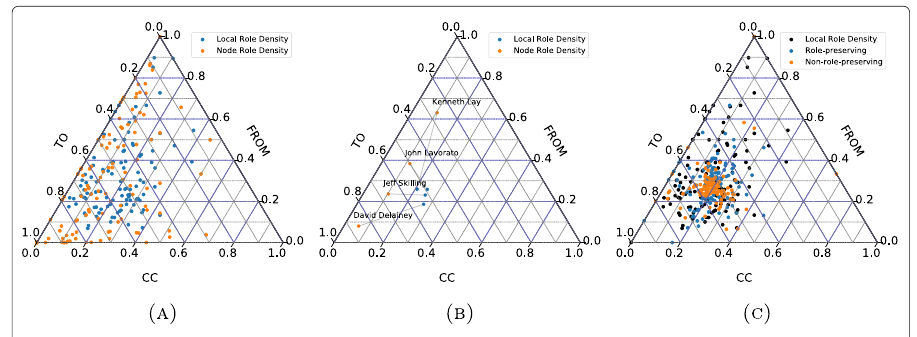
Fig. 1 Role distributions in the Enron data set. a . The individual role densities (orange) and local role densities (blue). b . The individual role densities (orange) and local role densities (blue) of the four Enron CEOs, now with lines connecting the statistics for each node. c . The local role densities (black) compared with a single sample from the role-preserving ensemble (blue) and non-role-preserving ensemble